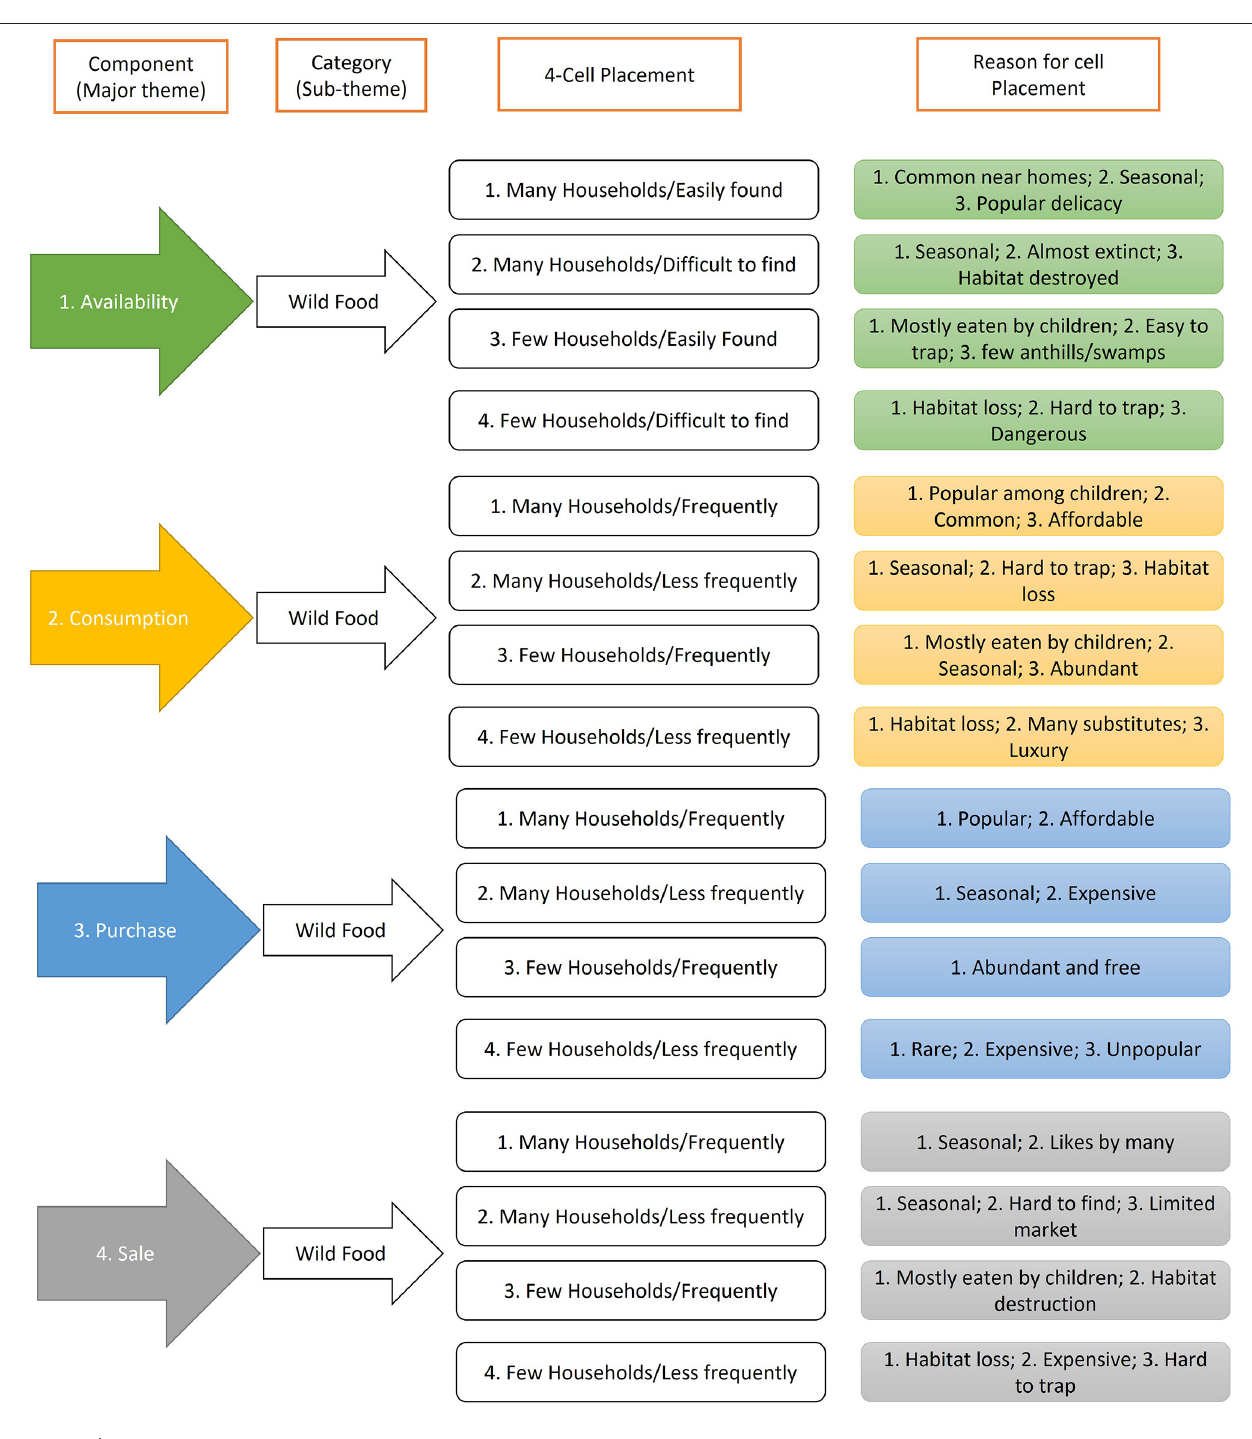
current period compared to fifteen species that were easily found by many households during the past period. Similar declining trends were also observed in the other villages in the Teso sub-